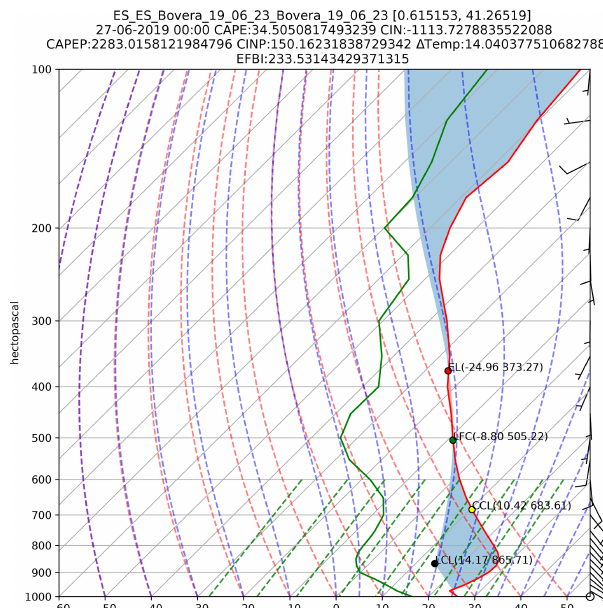
Figure 2. Sample of one skew-t plot for a given time step for the wildfire that took place in La Torre de l’Espanyol, Spain, and burnt 6625ha from 26 to 27 June 2019.